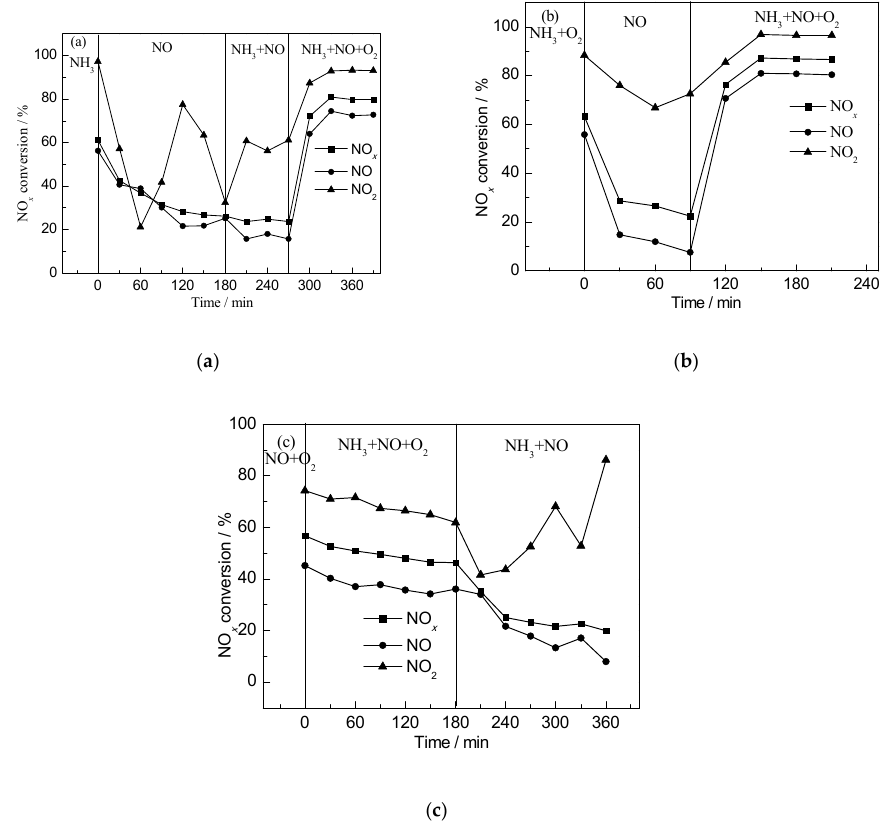
Figure 9. Transient SCR (selective catalytic reduction) activity tests (250 °C) under different pre-adsorption conditions: ( a ) pre-adsorption of NH 3 ; ( b ) pre-adsorbed of NH 3 and O 2 and ( c ) pre-adsorption of NO + O 2 .